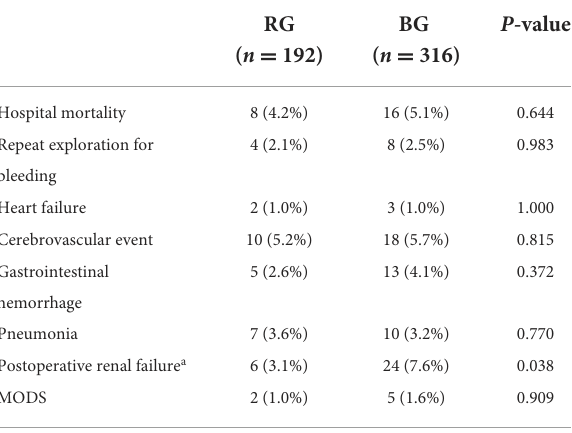
TABLE 3 Hospital mortality and morbidity.